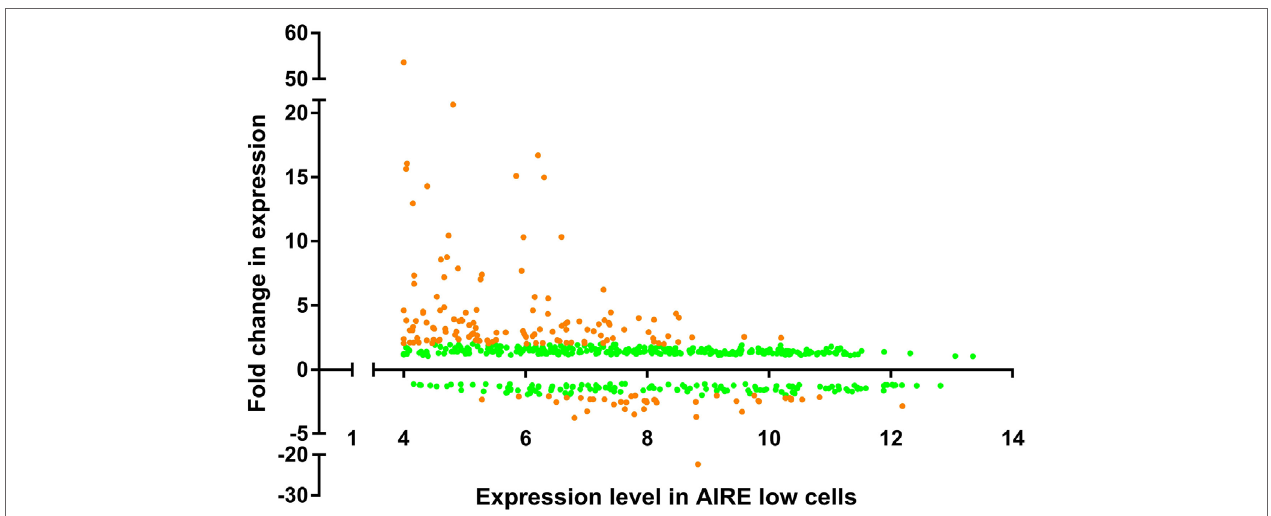
FigUre 3 | Gene expression profile of TEC 1A3 AIRE lo cells vs relative change in expression between AIRE hi and AIRE lo cells. Gene expression values are averaged from three replicates and relative change in expression values calculated for all probes on the Human Genome U133 Plus 2.0 gene array. All dots show probes with a significant change in expression ( P ≤ 0.05 with Benjamini–Hochberg correction), and orange dots show probes with significant change in expression ≥